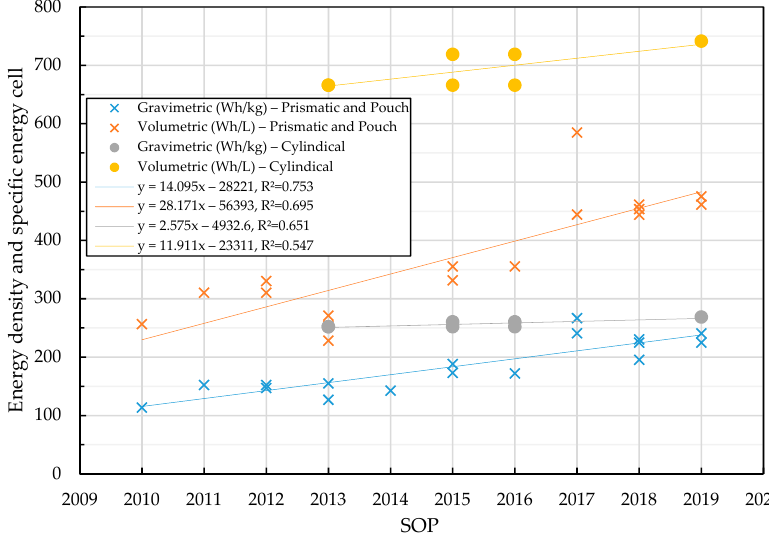
Figure 4. Development of specific energy (Wh/kg) and energy density (Wh/L) on cell level of various electric vehicles in the years between 2010 and 2019. Tesla with Cylindrical Cells shown separately.